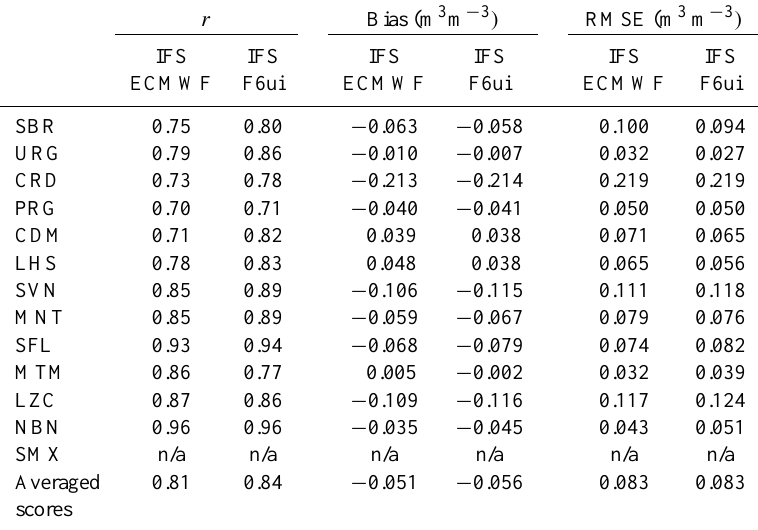
Table 6. Evaluation of operational soil moisture products from ECMWF for the second layer of soil (7–28cm) using the SMOSMANIA in situ soil moisture (20cm depth) over a one year period (July 2008–June 2009). The last row is for the average of the 12 stations.